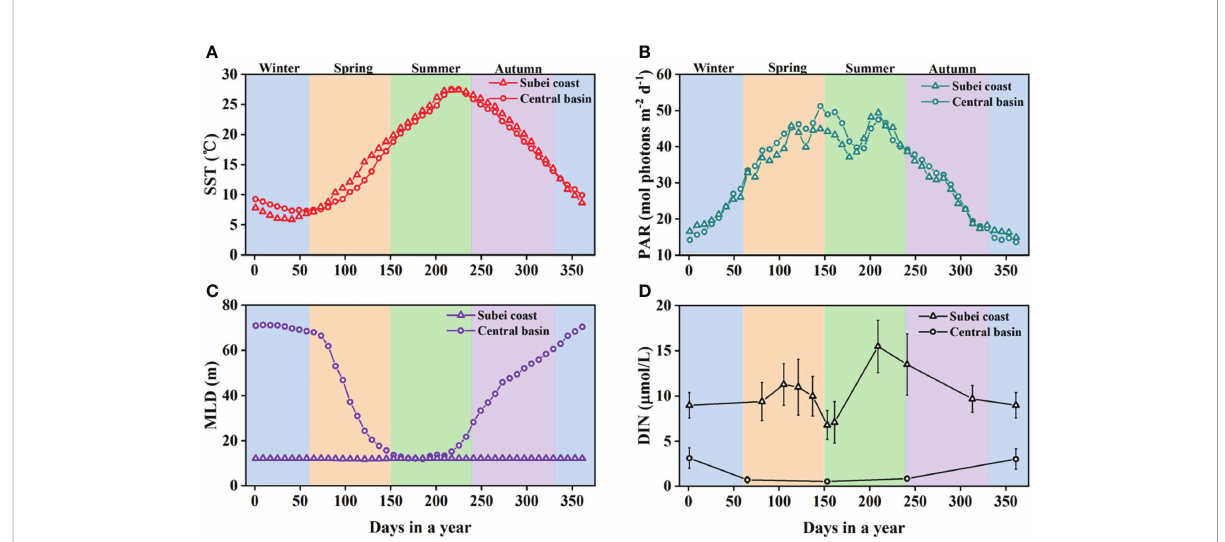
FIGURE 2 Temporal variations of sea surface temperature (SST, A ), photosynthetic active radiation (PAR, B ), mixed layer depth (MLD, C ), and dissolved inorganic nitrogen (DIN, D ) in the central basin of the South Yellow Sea (SYS) and the Subei coast region. Remote sensing data of 8-day SST, PAR, and MLD with 4-km spatial resolution were used to present their temporal variations throughout the year (https://oceancolor.gsfc.nasa. gov/). The SST, PAR, and MLD data are displayed as mean climatological data from the previous two decades, as reported by Niu et al. (2021). Observational DIN data are obtained from those seasonal sampling surveys at the surface or above the mixed layer (Shi et al., 2015; Guo et al., 2020; Wang et al., 2020). The continuous change of DIN throughout a year was derived by linearly interpolating the seasonal